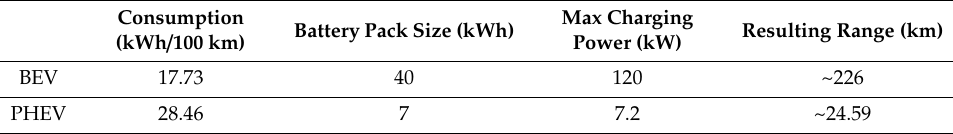
Table 3. Electric Vehicle Assumptions for Simulation.